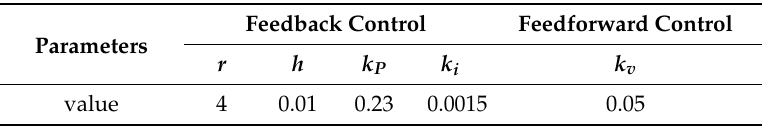
Table 6. Parameters of longitudinal control for real bus experiments.